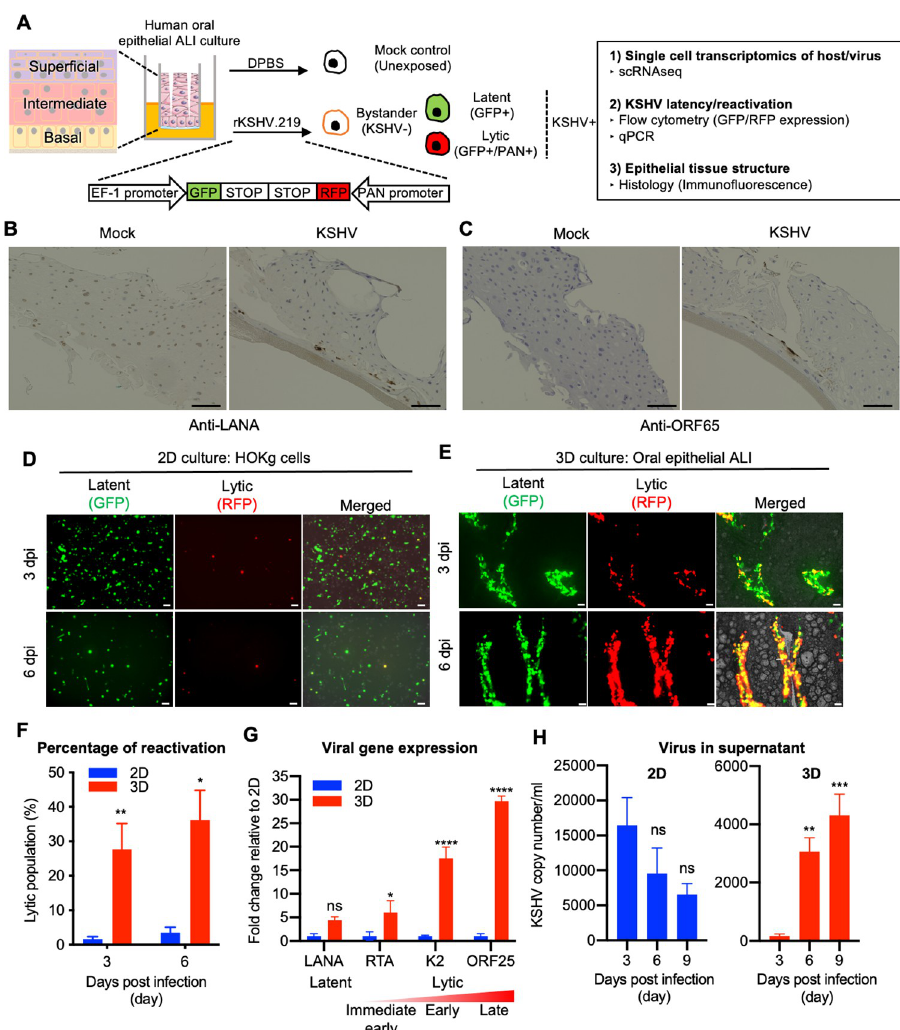
Fig 1. KSHV infection of primary oral epithelial ALI culture model shows more spontaneous reactivation than 2D monolayer culture. (A) Schematic of the experiment. Human 3D oral epithelial tissues consisting of basal (gold), intermediate (red), and superficial (purple) layers were wounded to expose the basal layer epithelial cells. The tissues where then infected with either DPBS or rKSHV.219 and harvested either 3 or 6 days post infection (dpi). Uninfected cells from the mock tissue are labeled as unexposed cells while uninfected tissues from the tissues exposed to rKSHV.219 are labeled as bystander cells. All cell types were used for 3 main studies: single cell transcriptomics of host and viral genes, KSHV latency and reactivation, and epithelial tissue structure. Fig 1A was created with a modified image from Servier Medical Art, which is licensed under a Creative Commons Attribution 3.0 Unported License (https://creativecommons.org/licenses/by/3.0/). Immunohistochemistry of KSHV LANA (B) or ORF65 (C) in mock or KSHV infected tissues at 6 dpi. Bars = 100 μ m. (D) GFP and RFP expression in cells infected with rKSHV.219 for 3 days and 6 days in HOKg 2D culture cells and (E) 3D epithelial tissues. The images are taken from above the cell cultures. Bars = 200 μ m. (F) Lytic population (Percentage of RFP+ and GFP+ expressing cells in GFP+ cells) were detected by FACS. (G) Quantification of LANA, (latency), RTA, (immediate early lytic), K2, ORF25 (early lytic), ORF25 (late lytic) mRNA levels in HOKg 2D culture cells and in 3D epithelial tissue infected with rKSHV.219 at 3 dpi. (H) KSHV genome copy number in supernatant of HOKg 2D culture cells (left) and 3D epithelial cultures (right) infected with rKSHV.219 at the indicated time point.